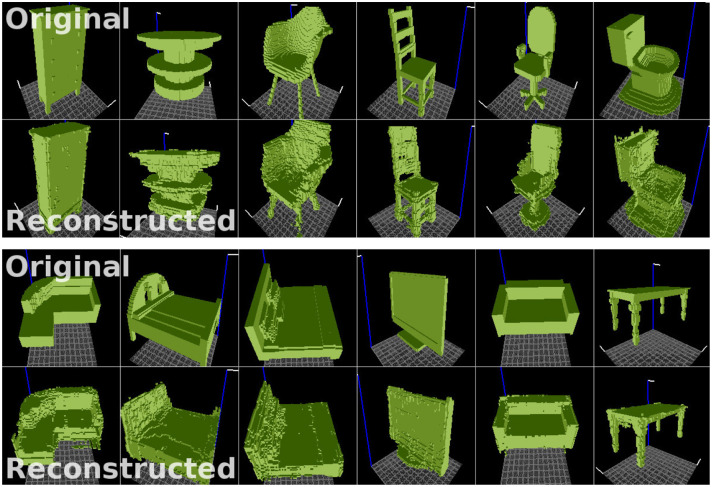
Examples of original voxelized objects (top) and their reconstructions (bottom) generated by the VAE. Objects taken from the ModelNet dataset (Wu et al., 2015). Visualizer: viewvox (Min, 2004).